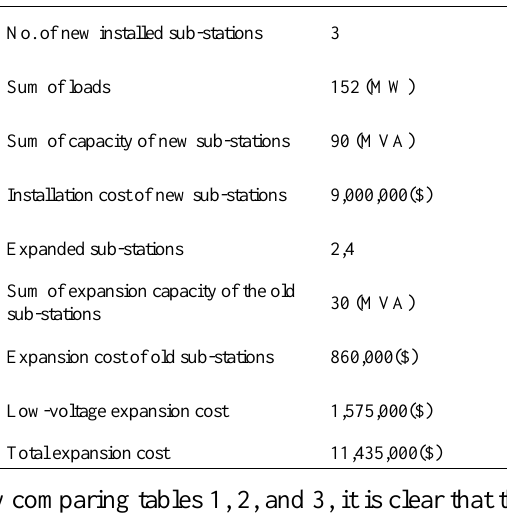
Table 3. Detailed results of applying BFOA to solve SEP problem on a typical network.